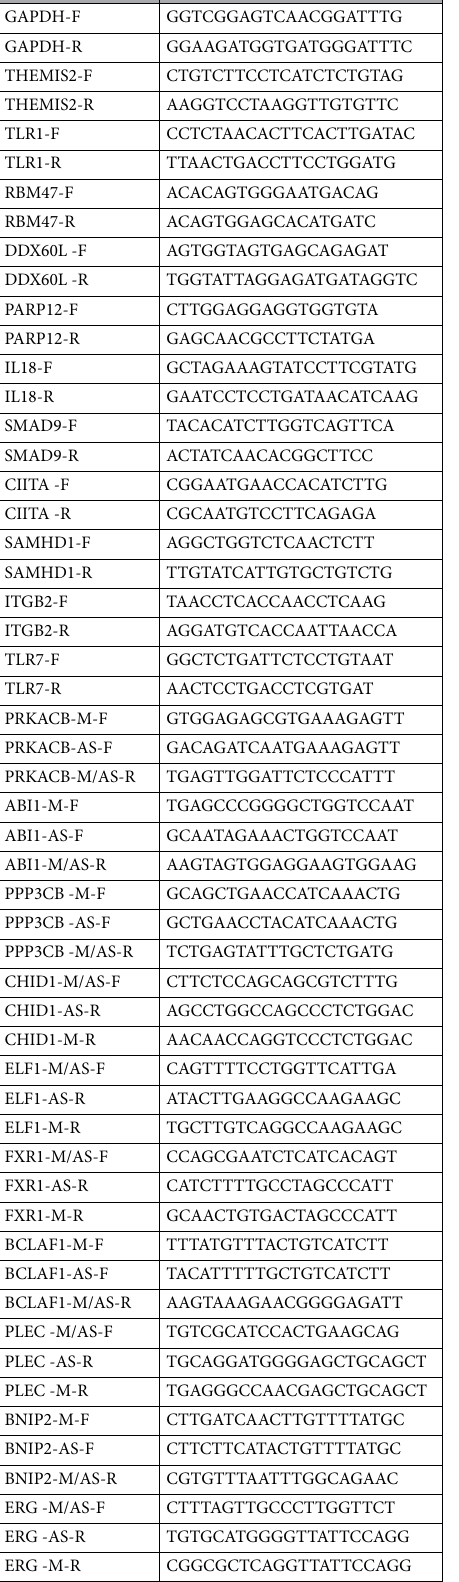
Table 1. The sequences of specific